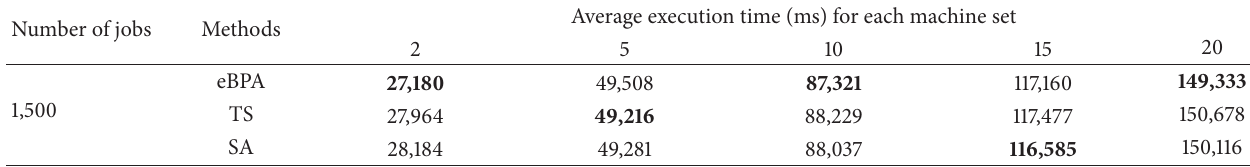
Table 4: The average execution times in milliseconds, per machine set, for the class of 1,500 jobs. Number of jobs